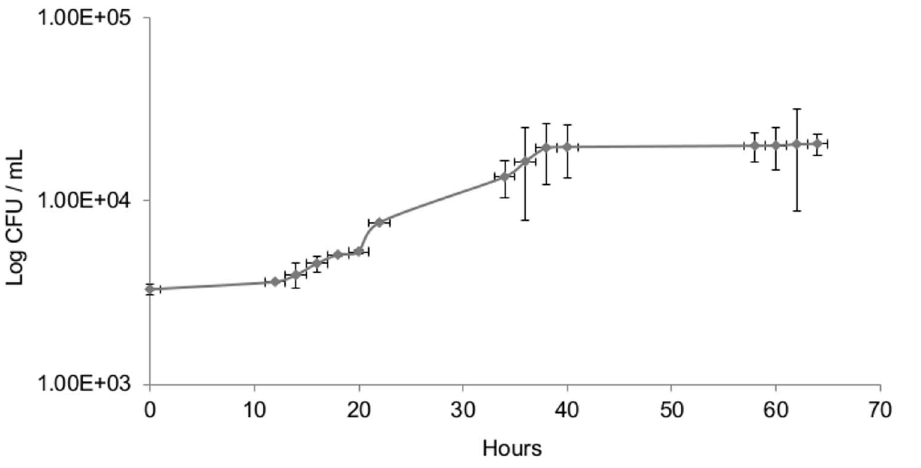
Figure 6. Growth of S.cerevisiae S288C in synthetic wine at 28 u C. Error bars indicate the standard deviations of three independent experiments. The generation time is equal to 10